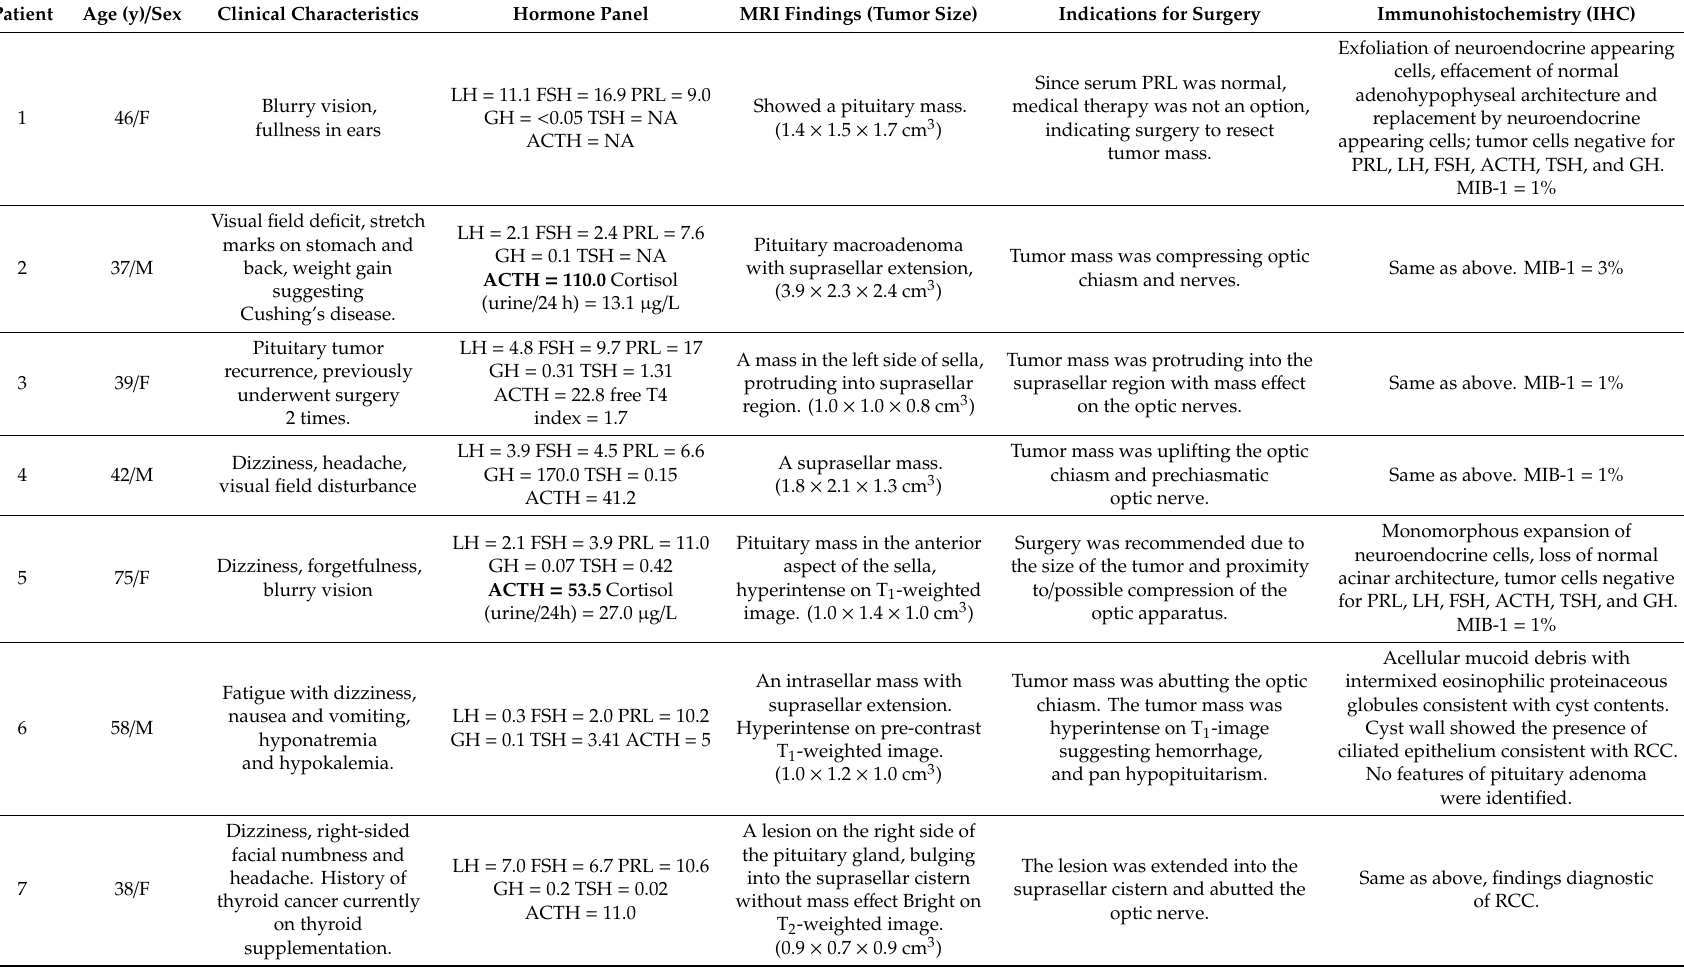
Table 1. Characteristics of patients with NF pituitary adenoma and